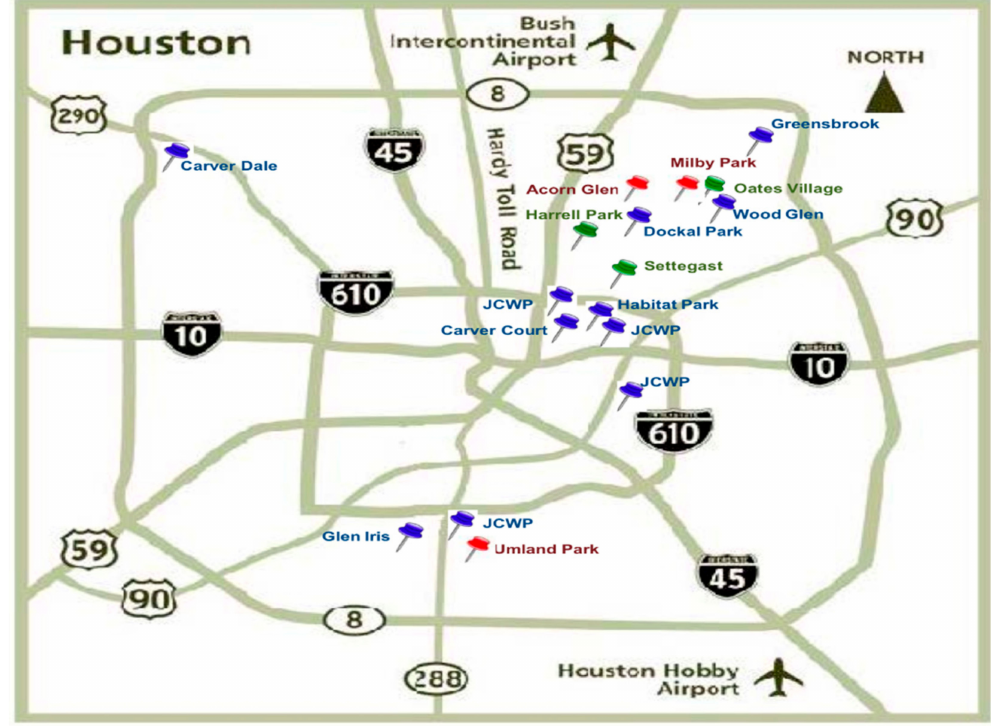
Figure 1. Map of Specific Houston Habitat Neighborhoods